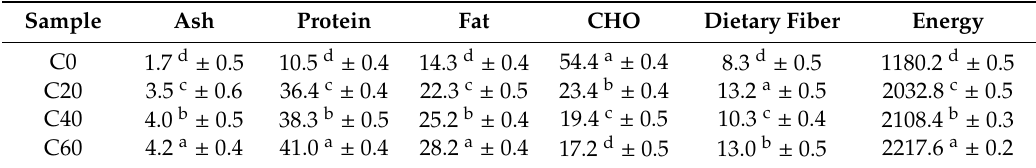
Table 2. The sorghum–termite blend on the proximate composition (g / 100 g) and gross energy (kJ) of cookies 1 .